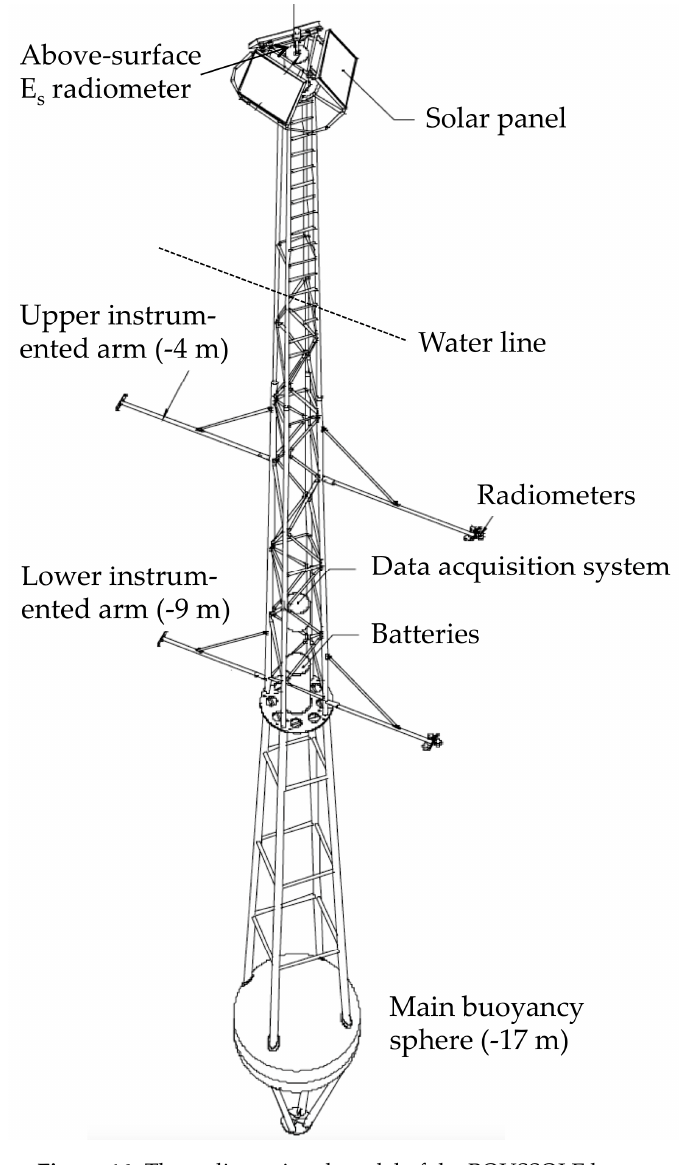
Figure 16. Three-dimensional model of the BOUSSOLE buoy.